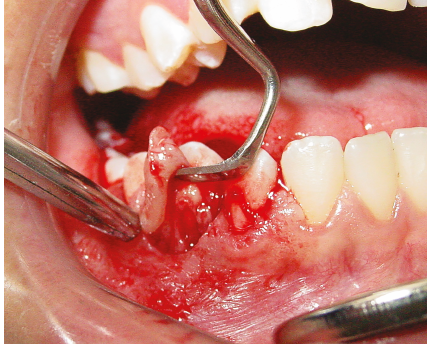
Figure 4: Excisional